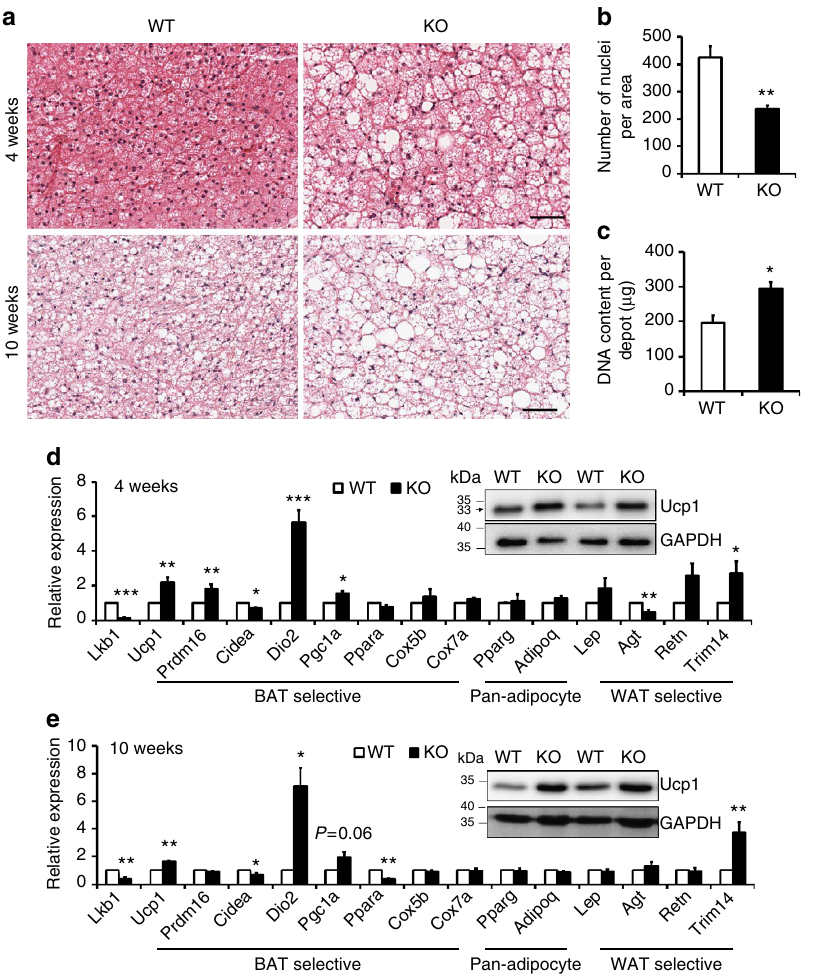
Figure 2 | Lkb1 deficiency leads to BAT hypertrophy and hyperplasia and increases the expression of BAT signature genes. ( a ) H&E staining of BAT sections from WT ( Lkb1 flox/flox ) and KO ( Adipoq-Lkb1 ) mice at 4 and 10 weeks old. Scale bars, 100 m m. ( b ) Number of nuclei per BAT image in WT ( n ¼ 9) and KO ( n ¼ 11) mice, from each mouse two random images were counted. ( c ) Genomic DNA content per BATdepot of WT ( n ¼ 3) and KO ( n ¼ 4) mice at 10 weeks old. ( d , e ) mRNA of pan-adipocyte, BAT- and WAT-selective genes in BAT from WTand KO mice at 4 weeks old ( d , n ¼ 7) and 10 weeks old ( e , n ¼ 7). Insets are western blots showing Ucp1 protein levels in BAT. Error bars represent s.e.m. * P o 0.05, ** P o 0.01, *** P o 0.001, two-tailed Student’s t